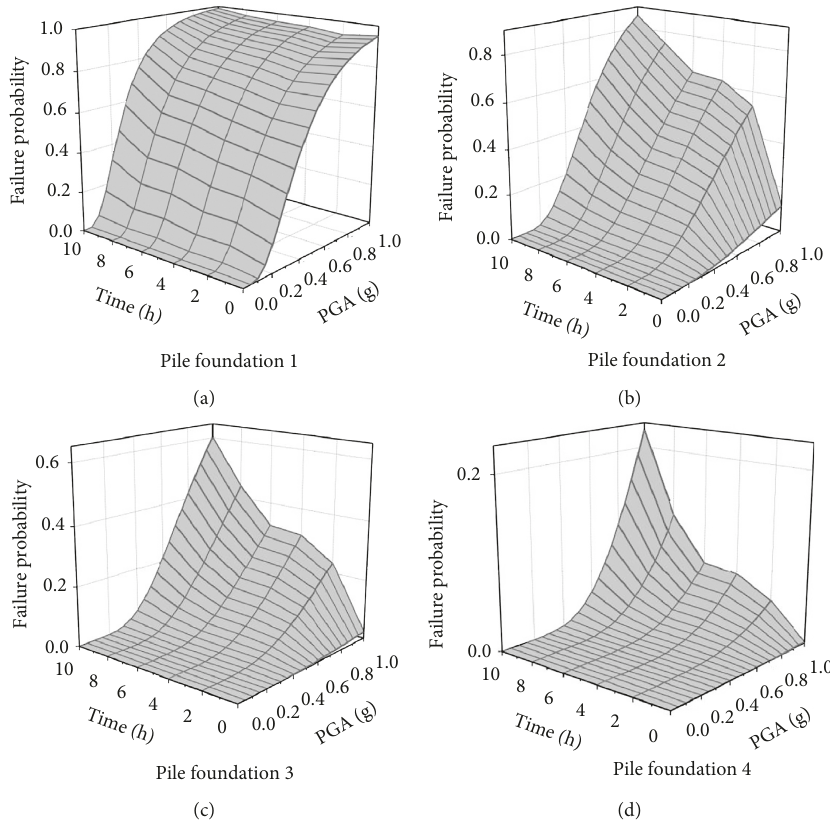
Figure 6: Seismic response characteristics of single pile under different seismic waves loading modes.